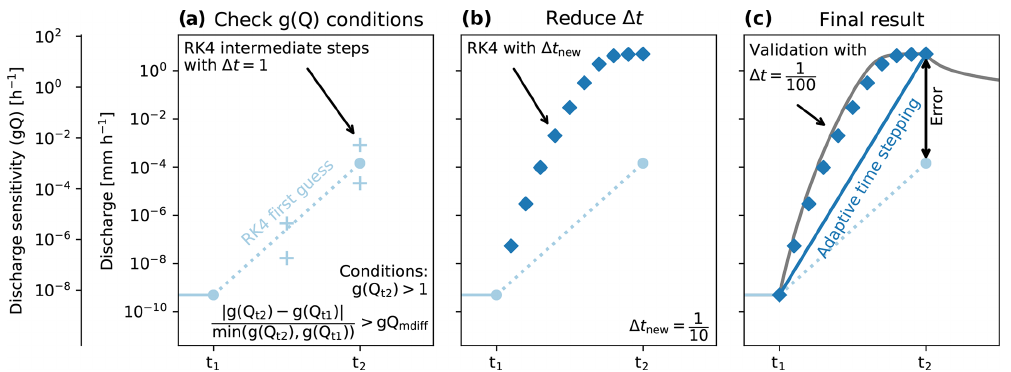
Figure 6. Three steps in the adaptive time stepping scheme. Note that in extreme cases both Q and g(Q) can change over several orders of magnitude between t 1 and t 2 , as can be seen from both y axes. The plus symbols in step 1 (a) indicate the intermediate values by the RK4 solver, which combine into the blue circle at t 2 . The blue diamonds in step 2 (b) show the intermediate steps calculated with RK4 but at a smaller time step. Only the value at t 2 is stored. The error in step 3 (c) represents the numerical error without the adaptive time stepping